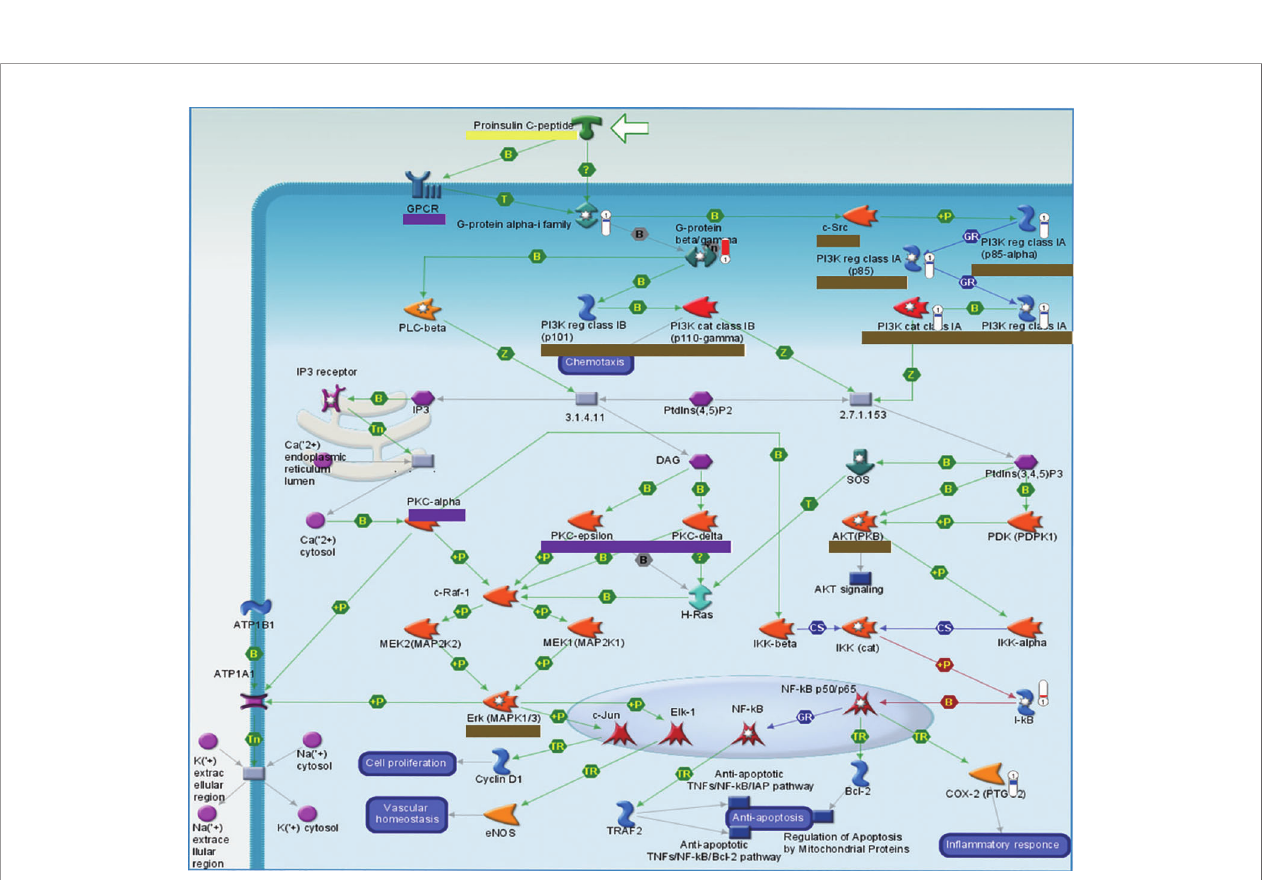
FIGURE 5 | The vertical converge of pathways comparison. Pathways which are triggered by BJ and JU are labeled with purple and brown solid line box, respectively. Pathway triggered by both BJ and JU is labeled with yellow solid line box.